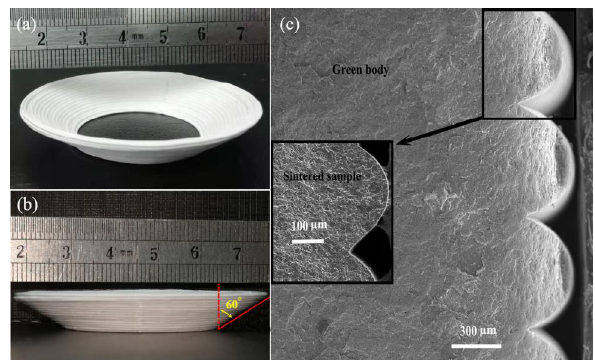
Fig. 6 Printed inclined-plane samples: (a, b) the green body with 60° inclined-plane printed and (c) the fracture surface morphology of interlamination for the printed green body and the sintered sample.